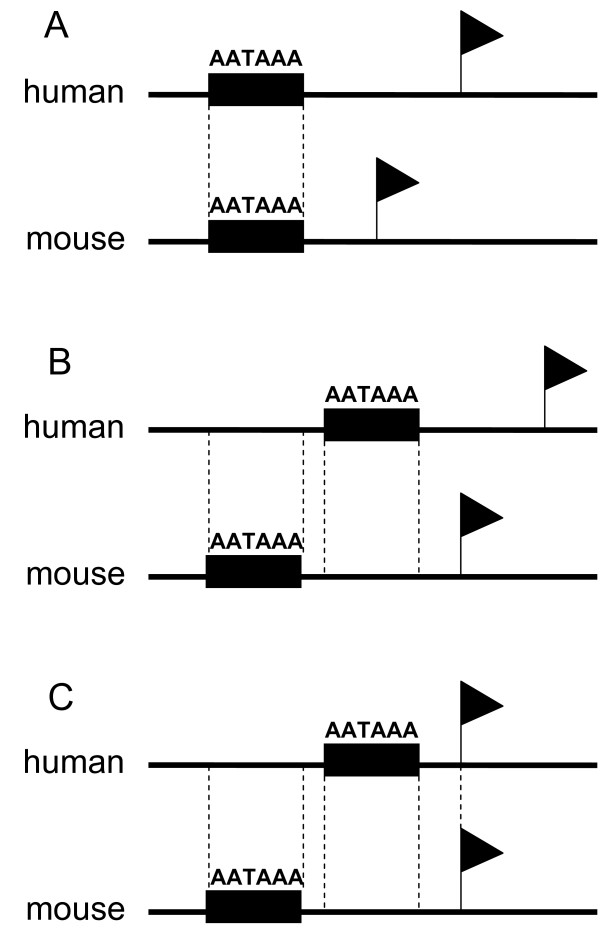
Definition of conserved and non-conserved polyadenylation sites. Cleavage sites are shown by flags and polyadenylation signals are shown by black squares. (A) sites are within 30 bp of each other and aligned associated signals: conserved; (B) sites are within 30 bp of each other, however, their associated signals are not aligned: non conserved; (C) although the sites themselves are aligned, their signals are not: non conserved.